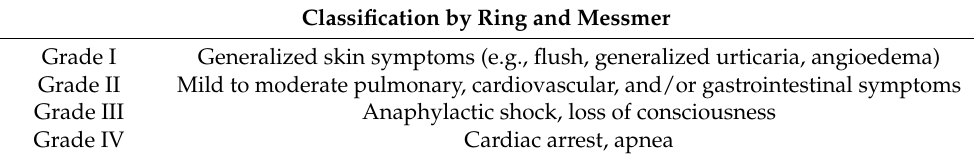
Table 2. Classification of anaphylaxis severity